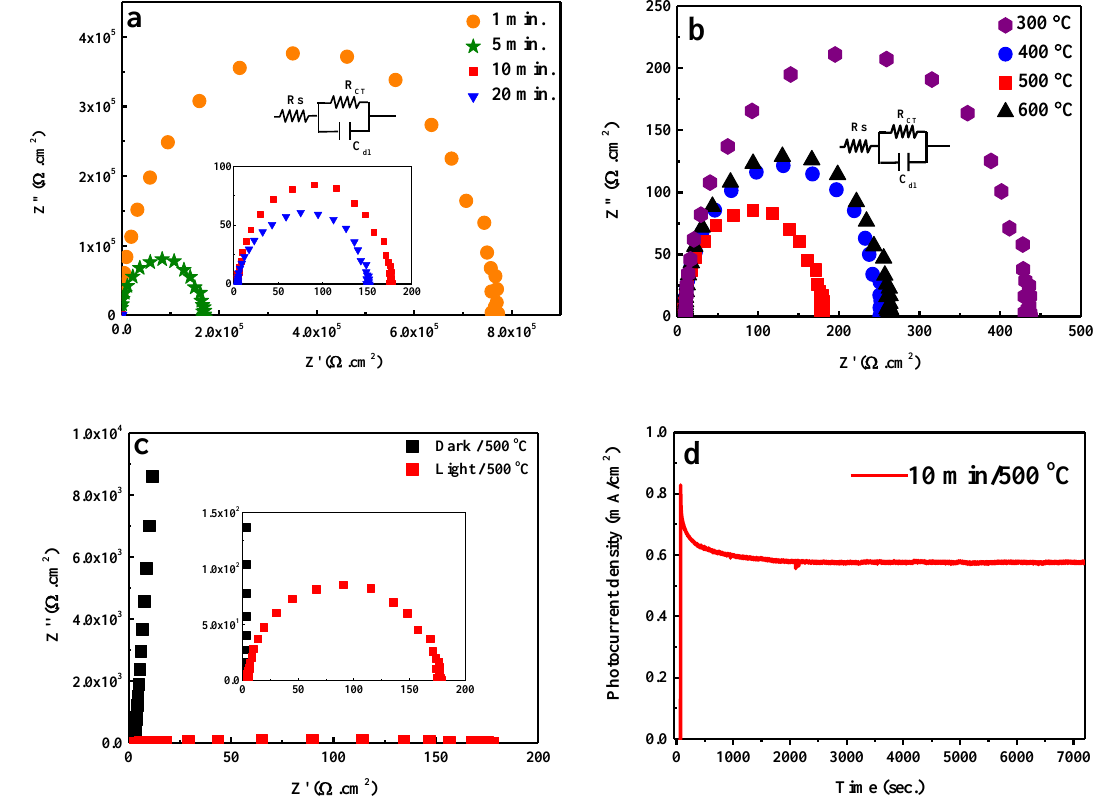
Figure 7. ( a ) Nyquist plots of W 18 O 49 films deposited for 1, 5, 10, and 20 min under light. ( b ) Nyquist plots of W films annealed at 300, 400, 500, and 600 ◦ C under light. ( c ) Nyquist plots of W 18 O 49 films deposited for 10 min and annealed at 500 ◦ C under dark and light. ( d ) Stability test of W 18 O 49 films deposited for 10 min and annealed at 500 ◦ C under light for 7200 Table 1. A comparison between the optimized W 18 O 49 film fabricated at 500 °C in air and different tungsten oxide photo-anodes reported in the literature.